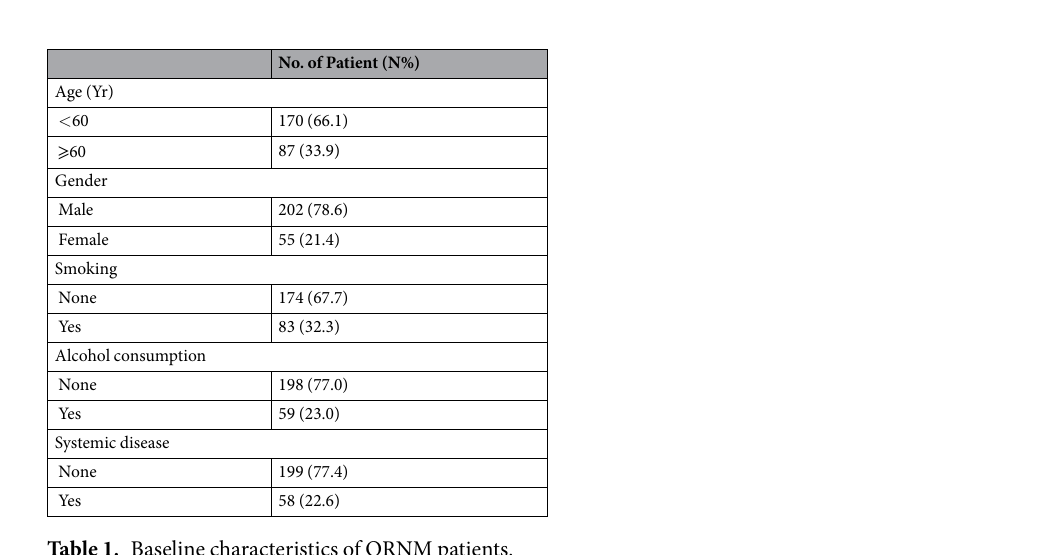
Figure 1. Flow diagram of patients selection.